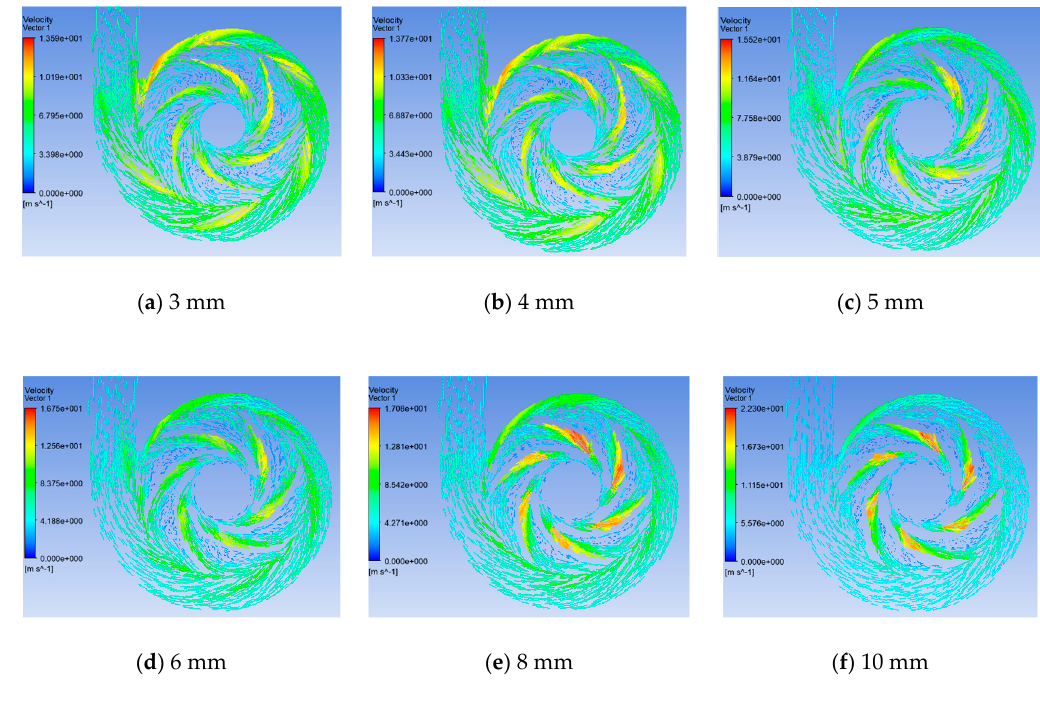
Figure 5. Velocity distribution of